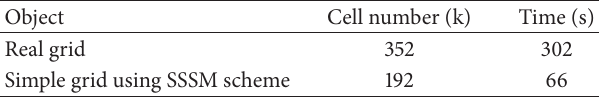
Table 10: Comparisons of the simulation